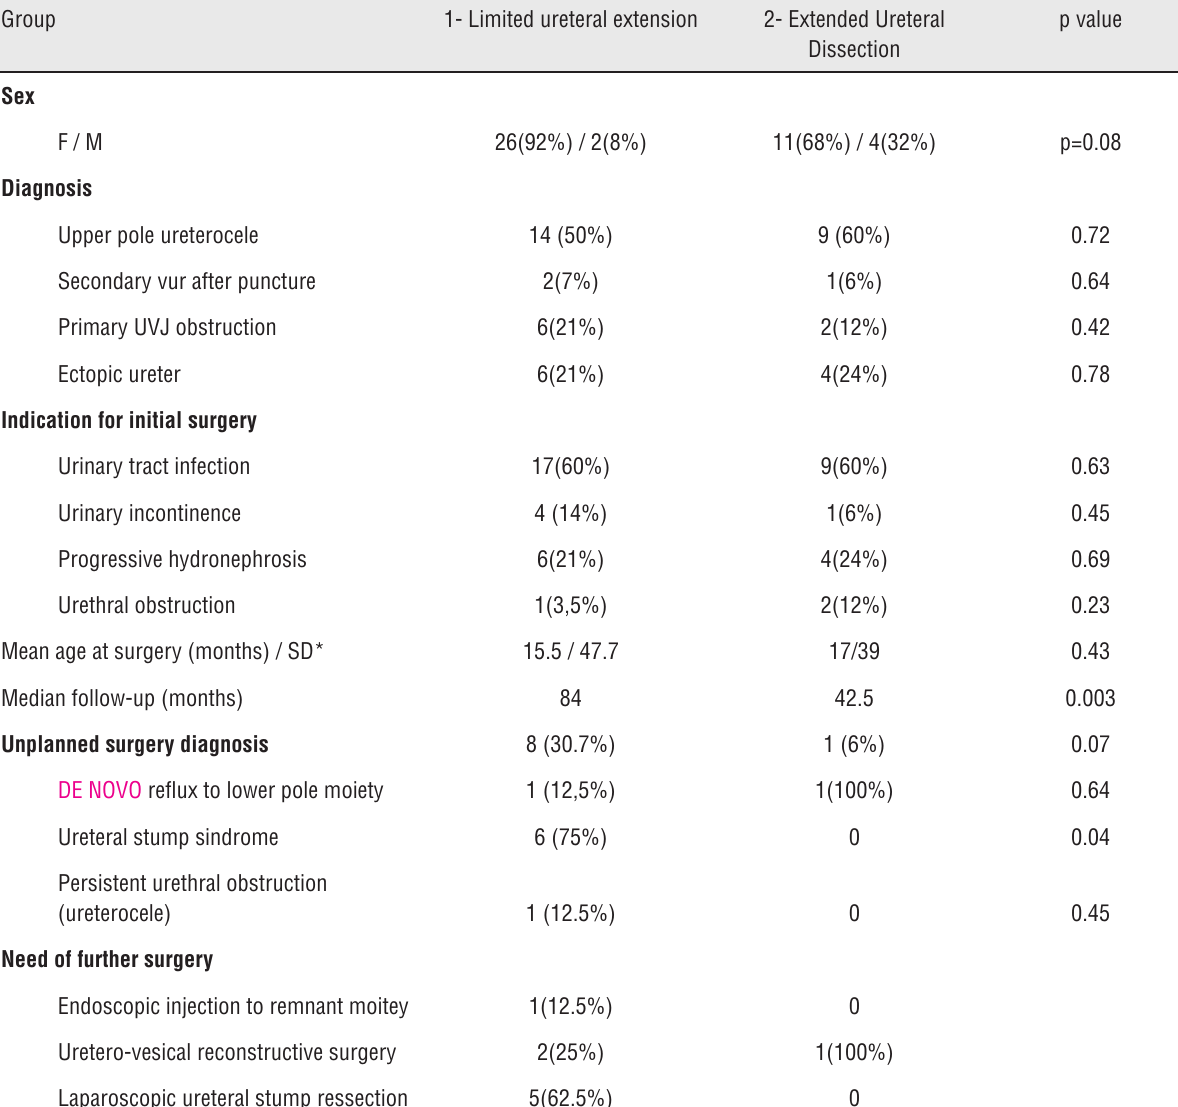
Table 1 - Demographics, follow-up, unplanned surgery diagnosis and need of further surgery. Group 1- Limited ureteral extension 2- Extended